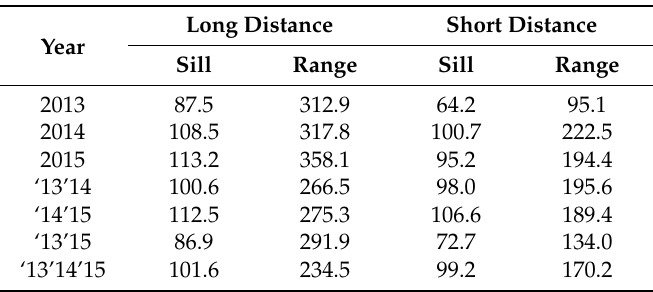
Figure 12. The 45° and 315° variograms at long distances for the first PC values ( a – g ) for all single (2013, 2014, and 2015) and multi-temporal composites (‘13’14, ‘14’15, ‘13’15, and ‘13’14’15). On the x-axis the distance (m) and on the y-axis the semi-variance. Table 10. Sill and range values for the large-scale variograms at short (750 m) and long (5000 m) distance (Figures 12 and 13).